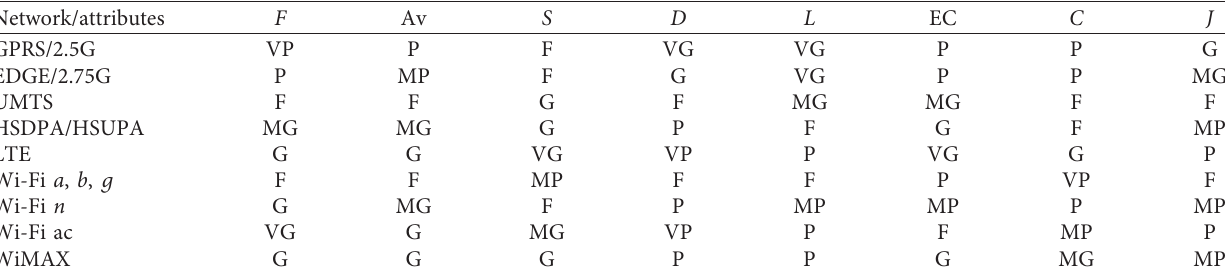
Table 4: Linguistic values of attributes used in the simulation of fuzzy MADM